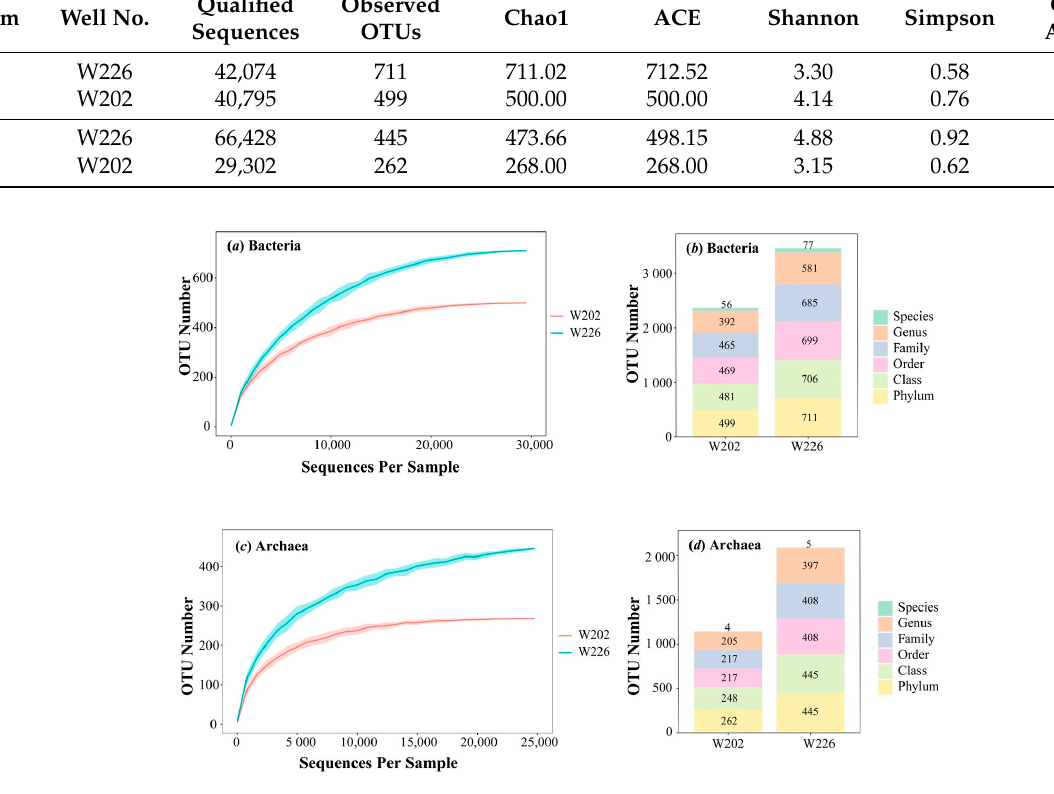
Figure 2. Community diversity of each sample. Rarefaction curves of observed bacterial ( a ) and archaeal ( c ) OTUs for the control and sampling wells. Distribution of bacterial ( b ) and archaeal ( d ) OTUs at different classification levels.